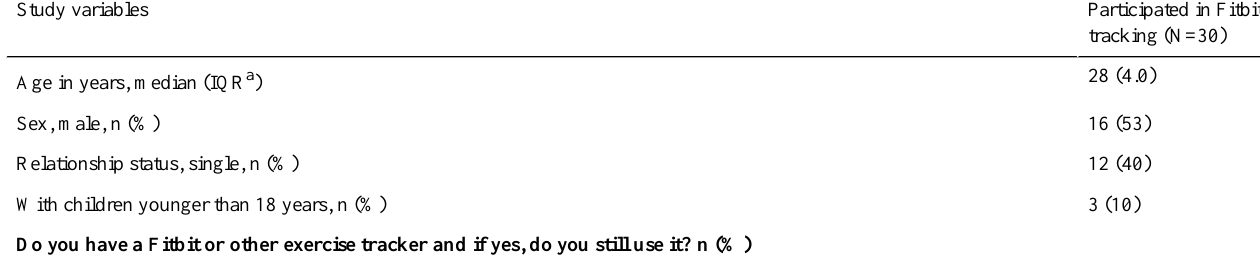
Table 1. Demographic characteristics, physical activity, and wellness perceptions among study